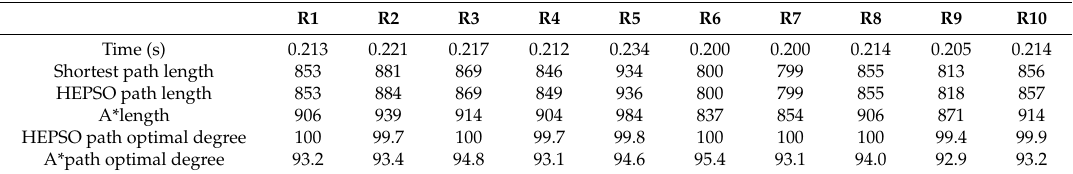
Table 1. Data for path planning on random obstacles maps.